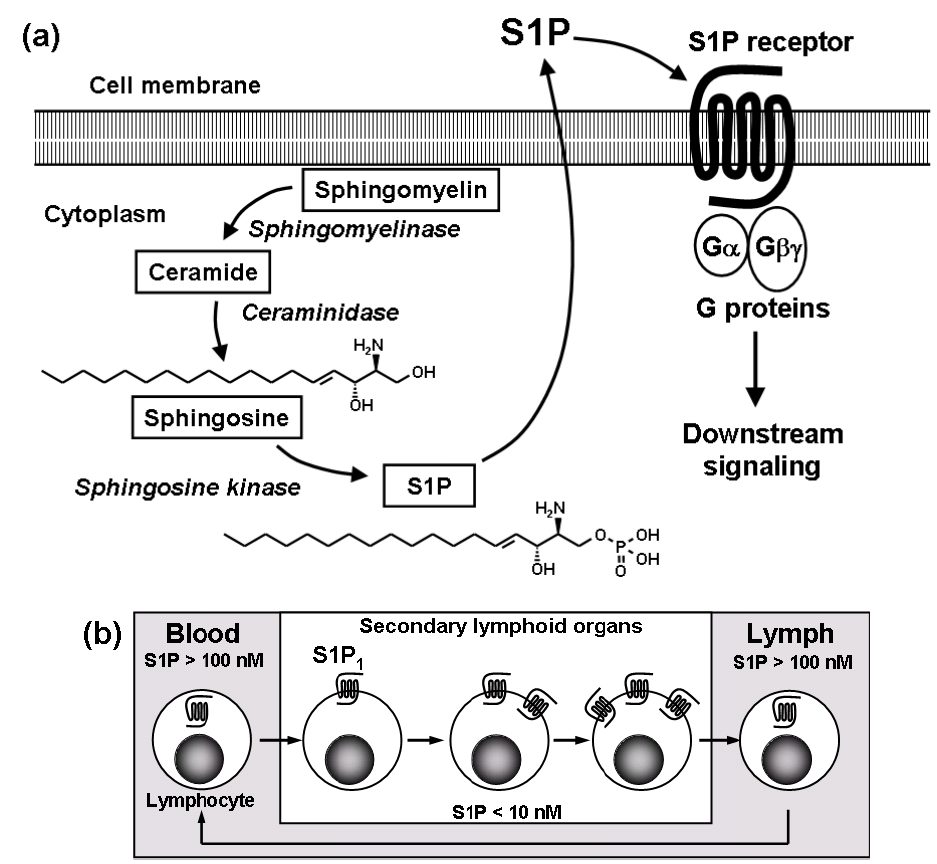
Figure 2. S1P plays an essential role in lymphocyte egress from the SLO. ( a ) S1P is 1 generated from sphingosine by sphingosine kinases and binds to S1P receptors; ( b ) Lymphocytic S1P is down-regulated in the blood, up-regulated in the SLO, and 1 down-regulated again in the lymph